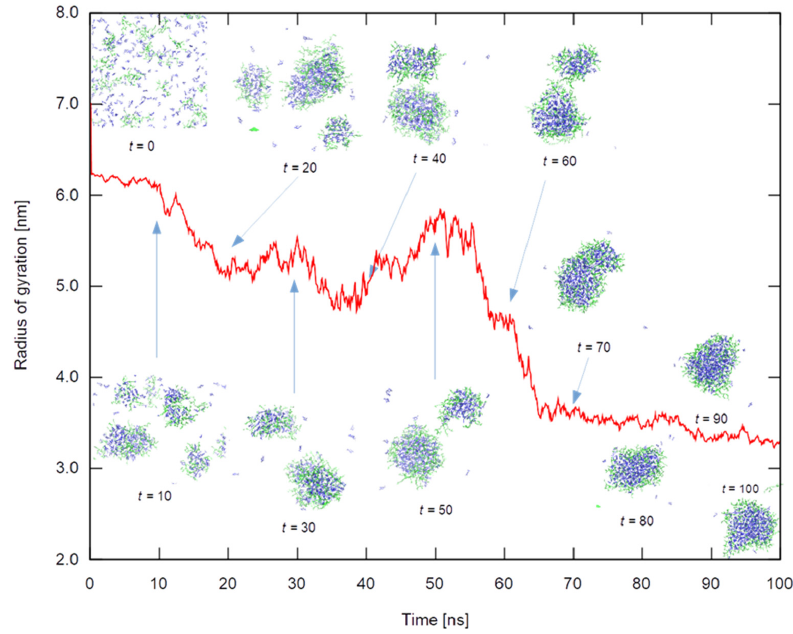
Figure 12. The radius of gyration, in nm, of the swarm consisting of all carvacrol molecules in the corresponding 27-chain HPG system against time. Snapshots of the system (solvent omitted) every 10 ns are also shown.